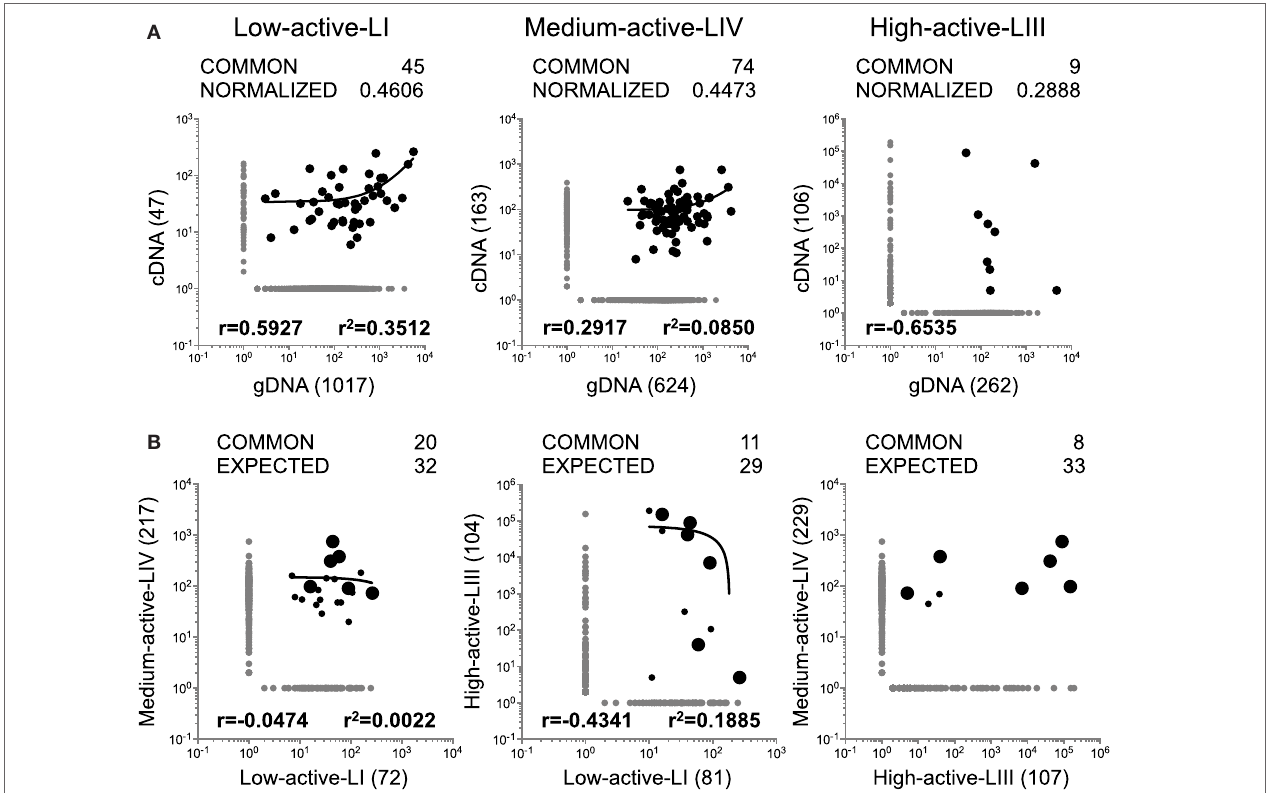
FigUre 3 | Analysis of TRBV repertoires in brain lesions by cDNA TRBV sequencing. (a,B) Logarithmic scatter plots comparing the number of copies of each clonotype identified by gDNA and cDNA sequencing in each brain lesion (a) and the number of copies of each clonotype (cDNA sequencing) infiltrating each pair of brain lesions (B) . Clonotypes not shared by brain lesions are shown in gray and clonotypes shared by brain lesions in black. Large symbols represent the six clonotypes shared by the three lesions. Actual, normalized and expected numbers of shared clonotypes as well as correlation coefficient ( r ) and coefficient of determination ( r 2 ) of their frequencies are shown in all scatters. Number of clonotypes not shared by the different samples are also shown in